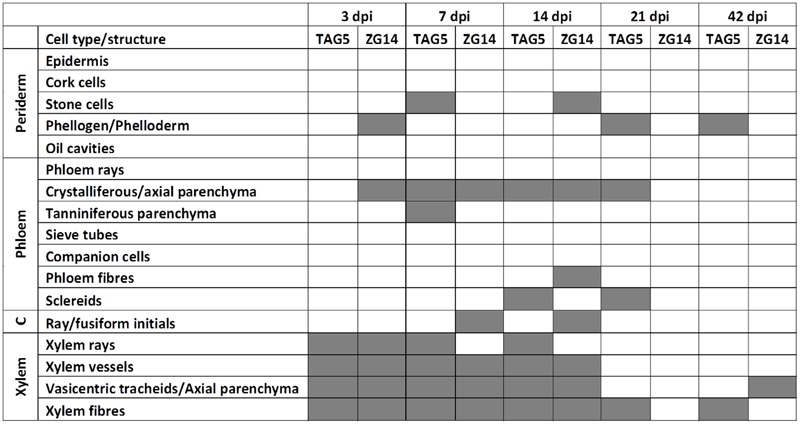
A summary of the location of C. austroafricana within highly susceptible and moderately resistant E. grandis clones at the inoculation site using safranin/fast green or lactophenol blue staining. C: cambium; dpi: days post-inoculation. Gray boxes indicate the presence of hyphae.